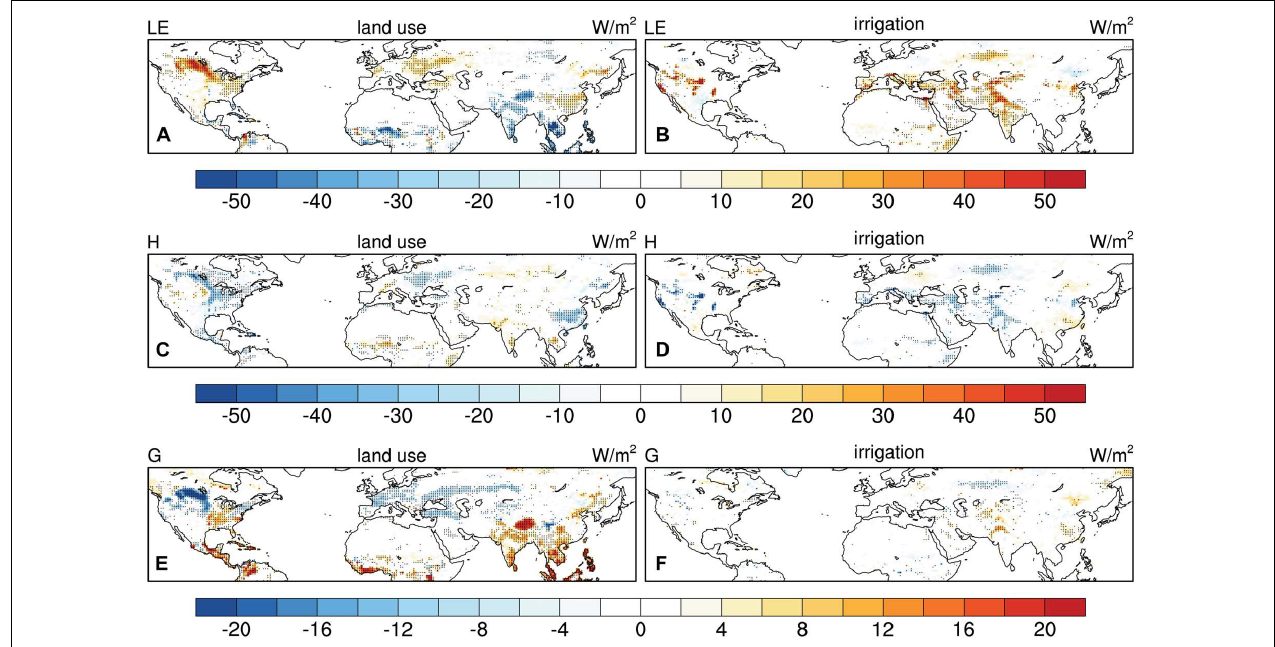
FIGURE 4 | Changes in summer daytime latent heat [LE in W/m 2 , (A,B) ], sensible heat [H in W/m 2 , (C,D) ], and ground heat [G in W/m 2 , (E,F) ] fluxes due to historical land use (left) and irrigation (right). Note that the scale of the label bar for G is different than those for LE and H. Stippling indicates significance at the 95% confidence